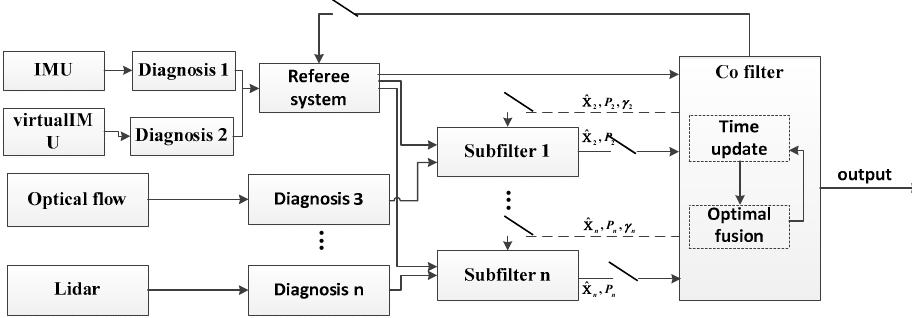
Figure 4. Information Fusion Scheme Diagram Based on No-reference System Fault Detection.